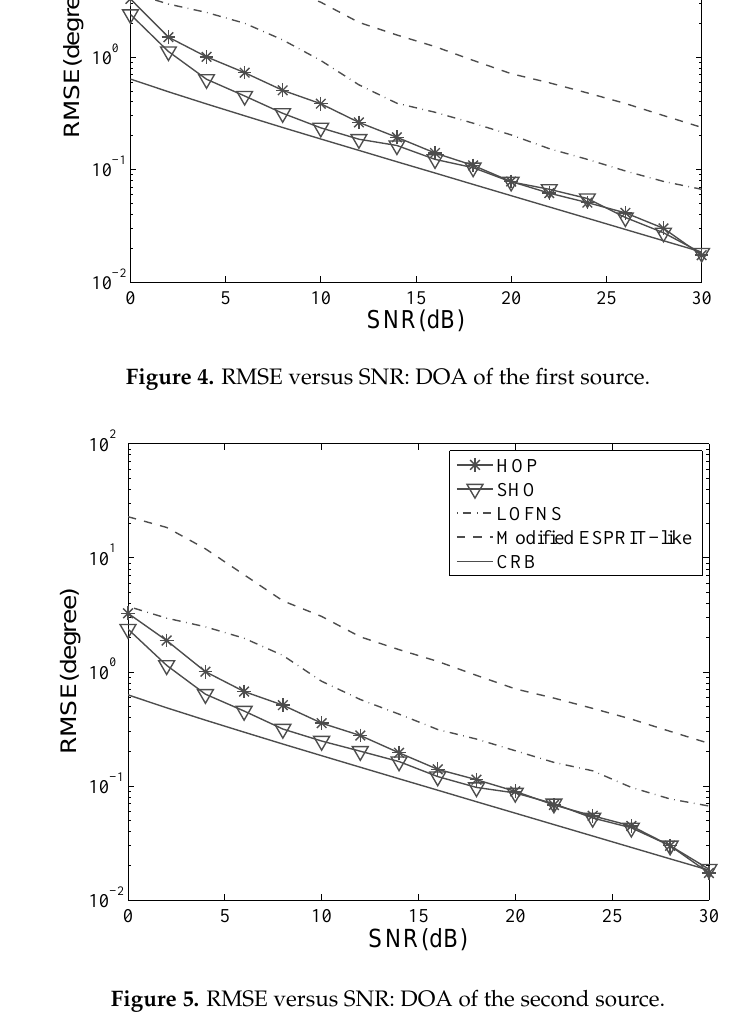
Figure 5. RMSE versus SNR: DOA of the second